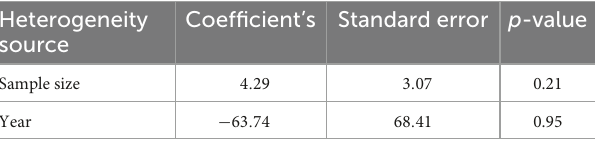
TABLE 2 Meta-regression analysis of factors affecting between-study